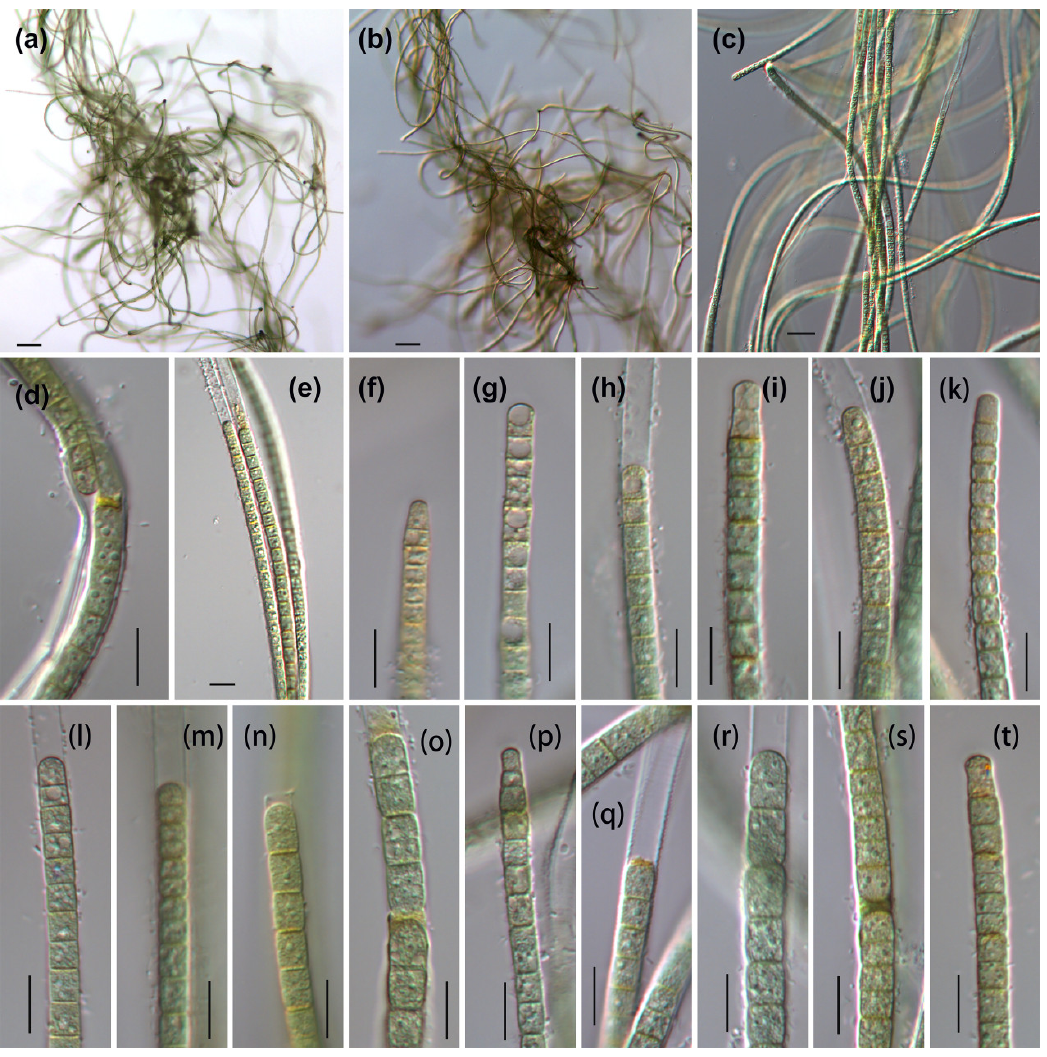
Figure 4. Light microscopy of Phormidium -like sp. 3 strains: ( a – c ) Numerous trichomes are densely entangled with each other; ( d – e ) detail of the sheath attached to filaments; ( f – n , p – r , t ) the details of various diversiform of apical cells; ( o , s ) detail of biconcave necridic cells. Scale bars: ( a , b ) = 50 μm, ( c , e ) = 20 μm, ( d , f – t ) = 10 μm. Habitat: At the bottom of the stream.